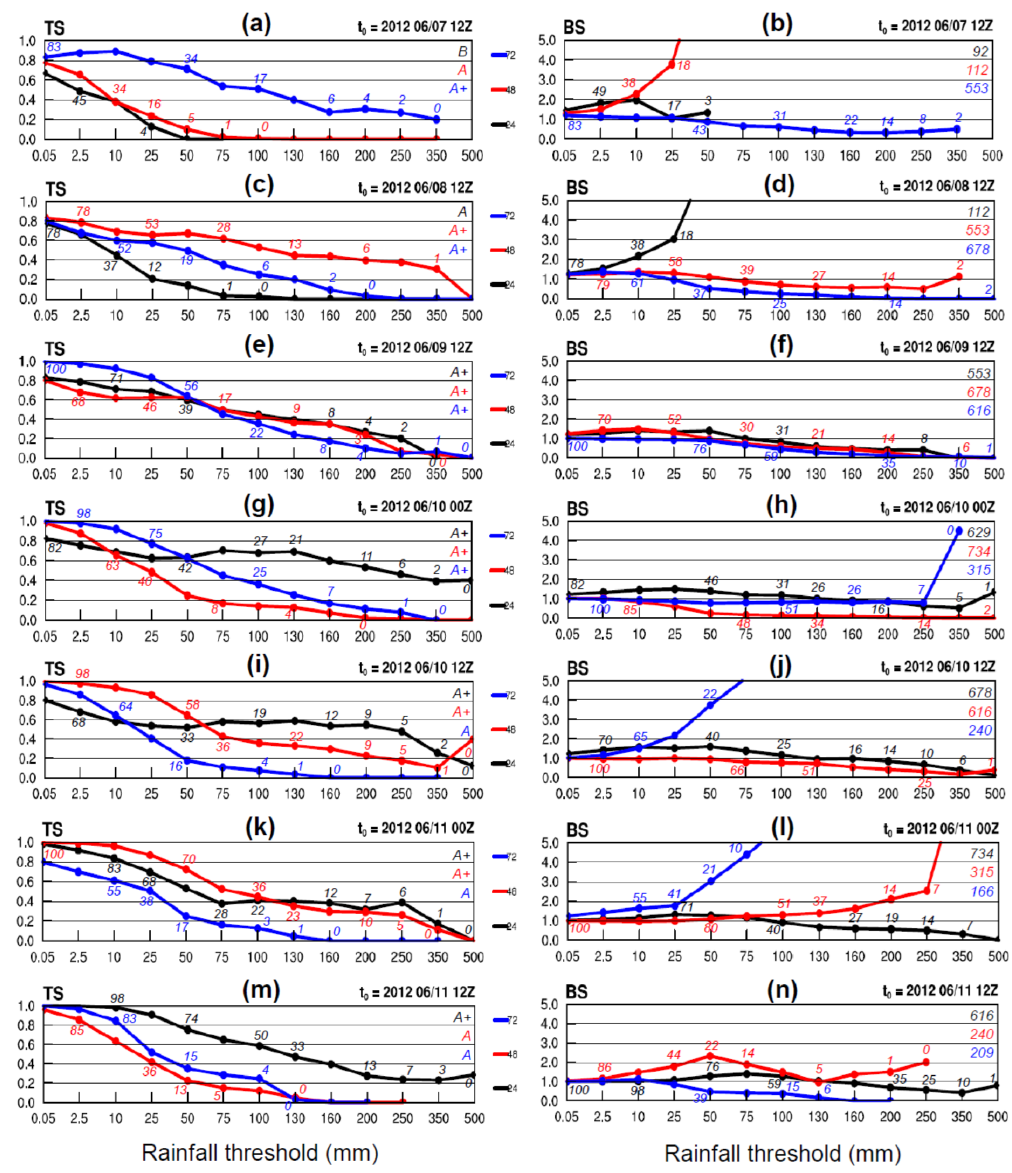
Figure 7. (a) TS and (b) BS of day − 1 (black), day − 2 (red), and day − 3 (blue) QPFs made at 12:00UTC 7 June 2012 as a function of rainfall threshold (mm; per 24h). The hit rate ( H/N ; %; rounded to integer) at selected points and the classification group for each day are labeled in the left panel (for TS). The observed base rate ( O/N ; %) and peak 24h rainfall (mm) are labeled in the right panel (for BS). (c, d) to (m, n) As in (a, b) , except for the QPFs made at (c, d) 12:00UTC 8 June, (e, f) 12:00UTC 9 June, (g, h) 00:00UTC and (i, j) 12:00UTC 10 June, and (k, l) 00:00UTC and (m, n) 12:00UTC 11 June 2012, respectively.